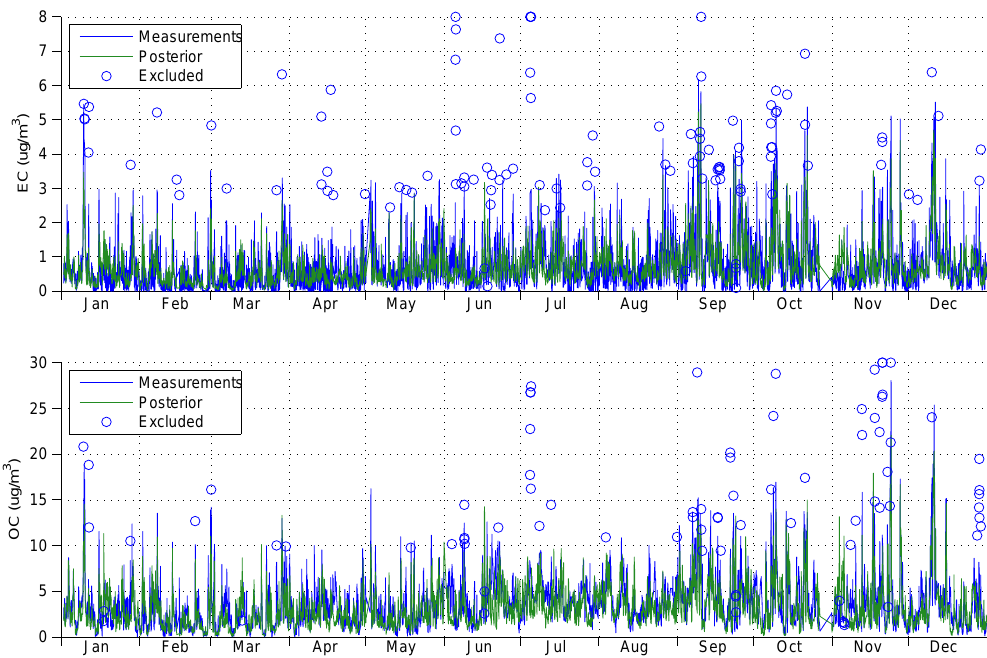
Figure 4. Time series of elemental and organic carbon at the St. Louis–Midwest supersite for 2002. Measurements are shown in blue, circles show the data points excluded from the analysis by the iteratively reweighted least squares scheme. Green line shows the posterior time series, as produced by the least squares inverse model.